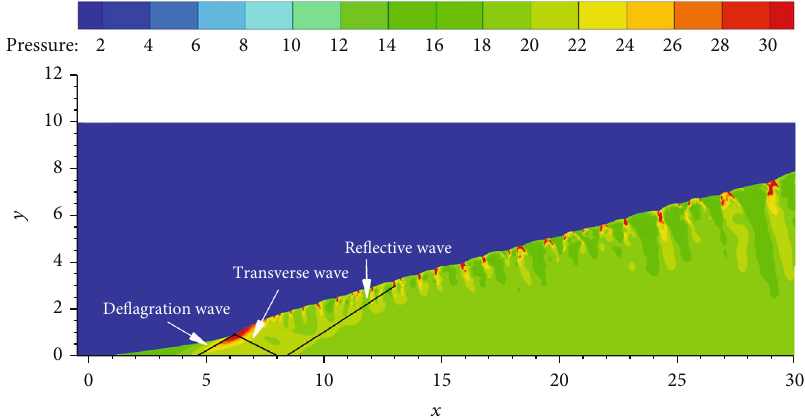
Figure 11: Interaction between the leading shock front and the re fl ection